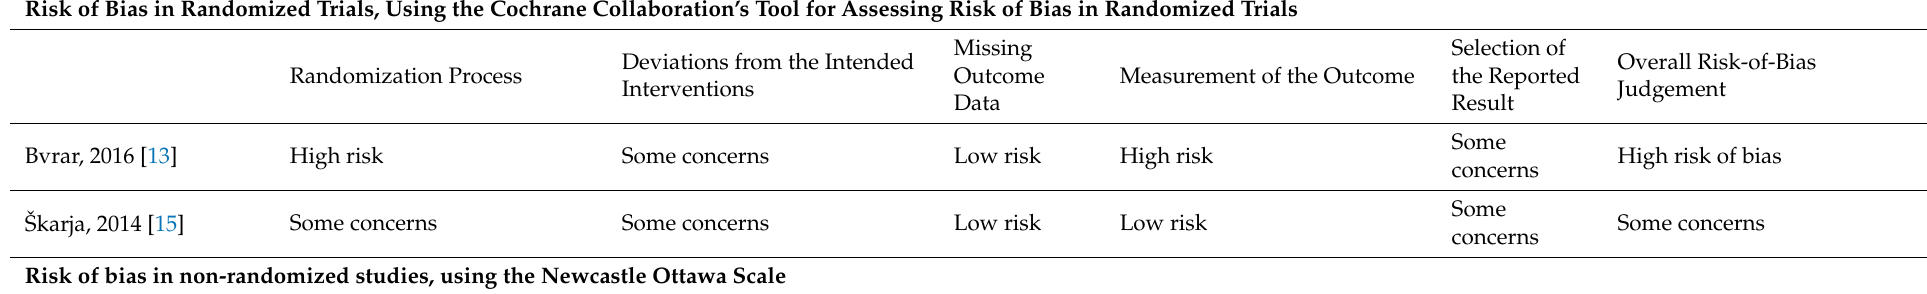
Table 3. Risk-of-bias assessment for studies assessing diphoterine compared with water or no treatment for chemical burns of the skin. Risk of Bias in Randomized Trials, Using the Cochrane Collaboration’s Tool for Assessing Risk of Bias in Randomized Trials